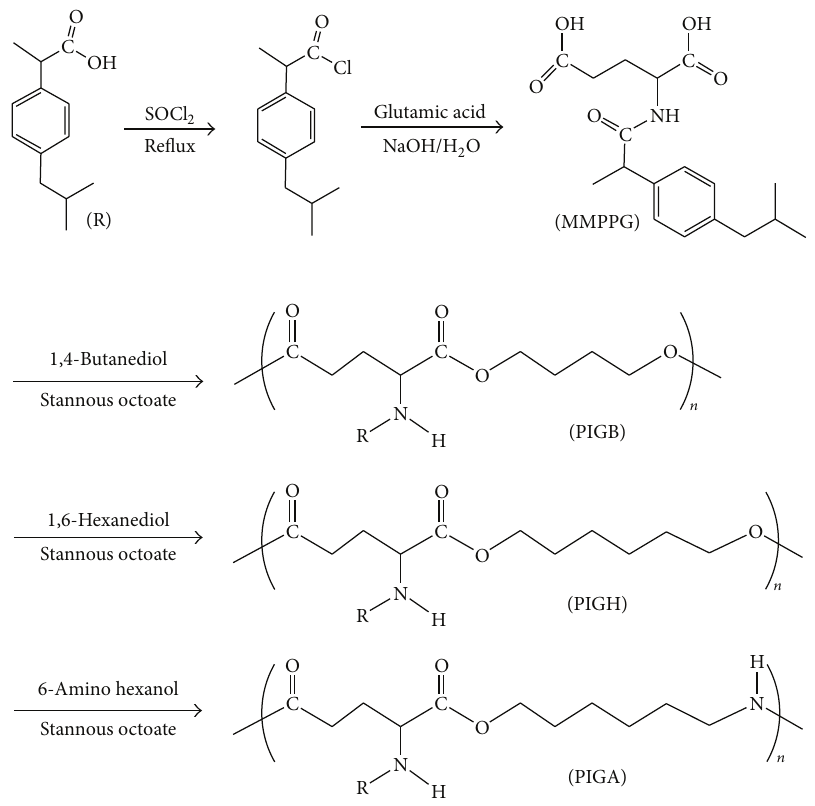
Figure 1: Synthetic routes of polymer carriers PIGB, PIGH, and PIGA.